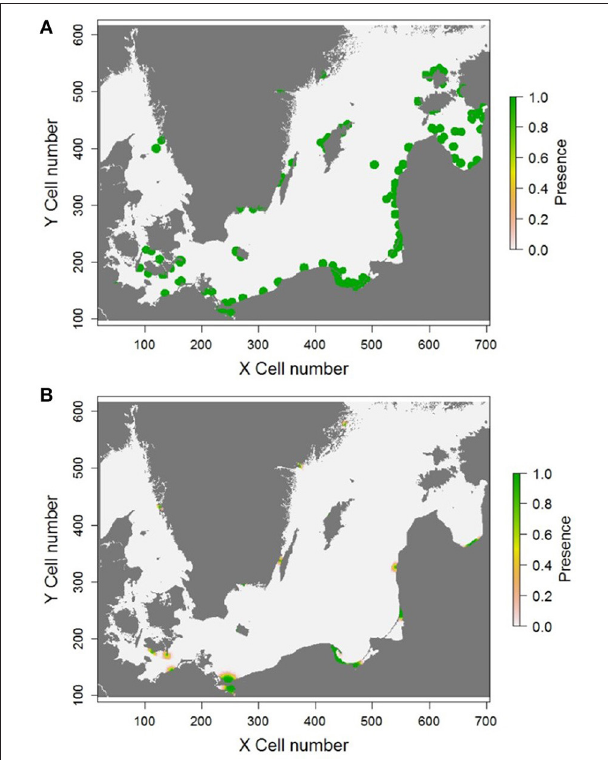
FIGURE 5 | Comparison between (A) , the observed goby distribution available from the literature, and (B) , an example predicted distribution obtained from the model. The color of the cell represents the presence of a population in a cell, and therefore its colonization in a repetition. The presence varies from one to zero, with a value of one meaning the cell was colonized in every repetition and a value of zero meaning the cell was never colonized. The values along the axis represent the cell numbers of the landscape grid used in the modeling exercise, in which each cell size was 2.5km.